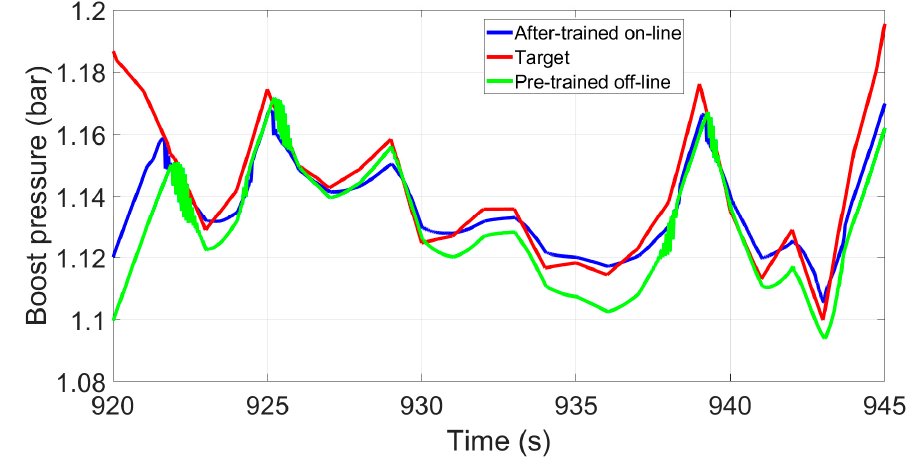
Figure 17. Control performance using the pre-trained off-line algorithm and the strategy after continuing on-line learning in the “real engine” simulation model. on-line learning in the “real engine” simulation